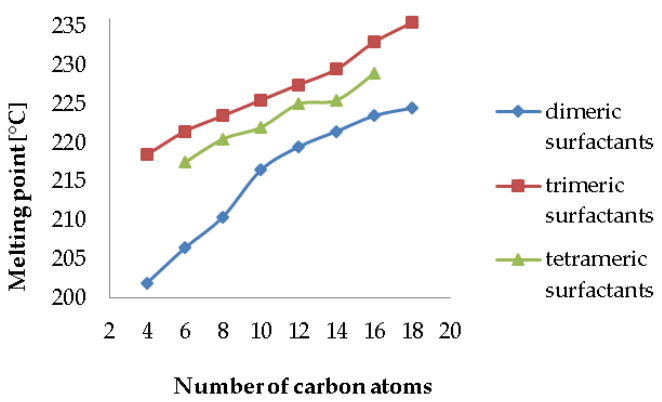
Figure 1. Melting points of dimeric ( 2 – 9 ), trimeric ( 10 – 17 ) and tetrameric surfactants ( 18 – 23 ).